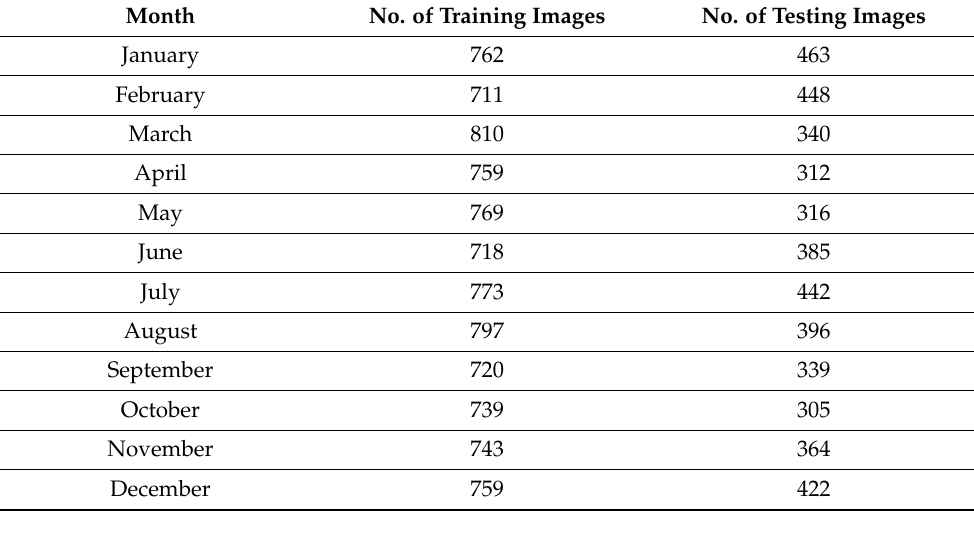
Table 1. Number of training and test images used to construct a deep network model (i.e., GIN) in each month.